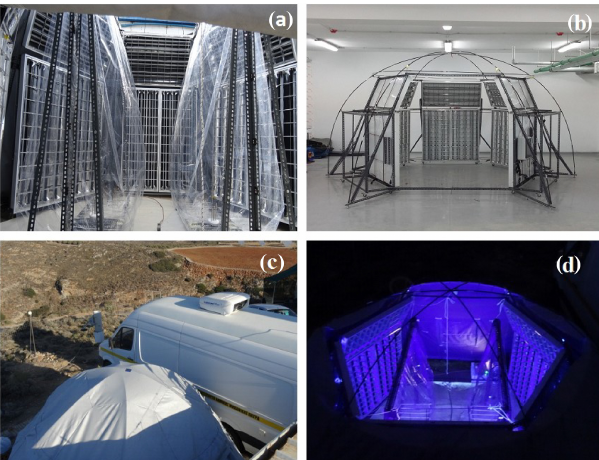
Figure 1. Pictures of the portable dual-chamber system: (a) the dual chambers; (b) UV light assembly; (c) field deployment during the FAME 16 study; (d) system configuration with the UV lights on and the top cover